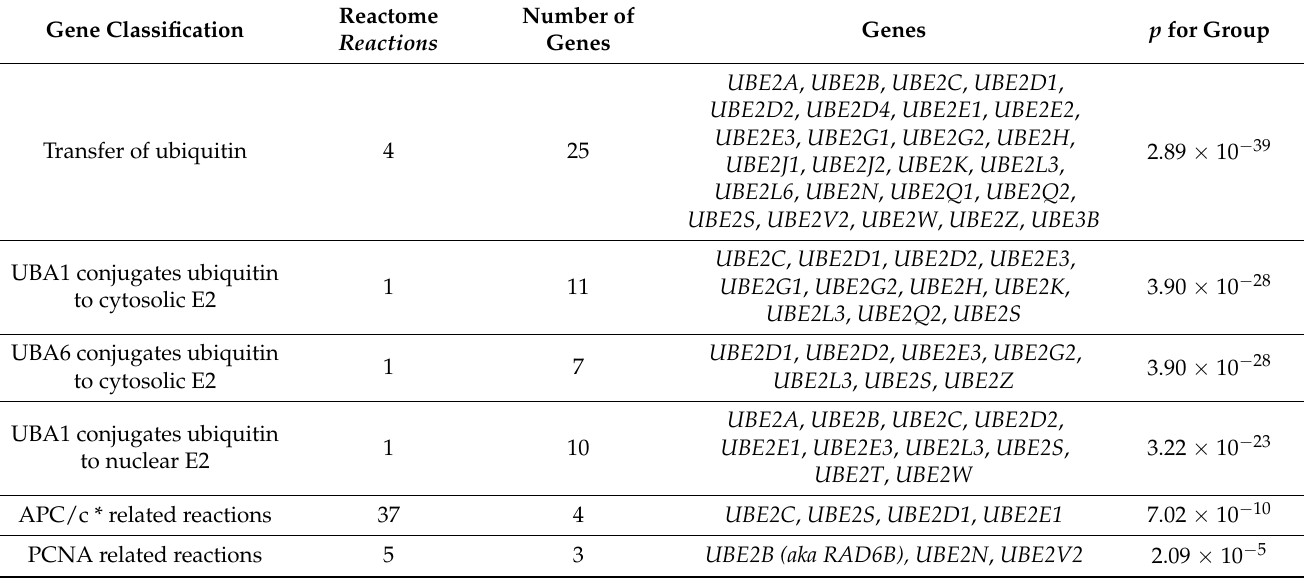
Table 3. Main Reactome Reactions over-represented by differentially expressed E2 conjugase genes.